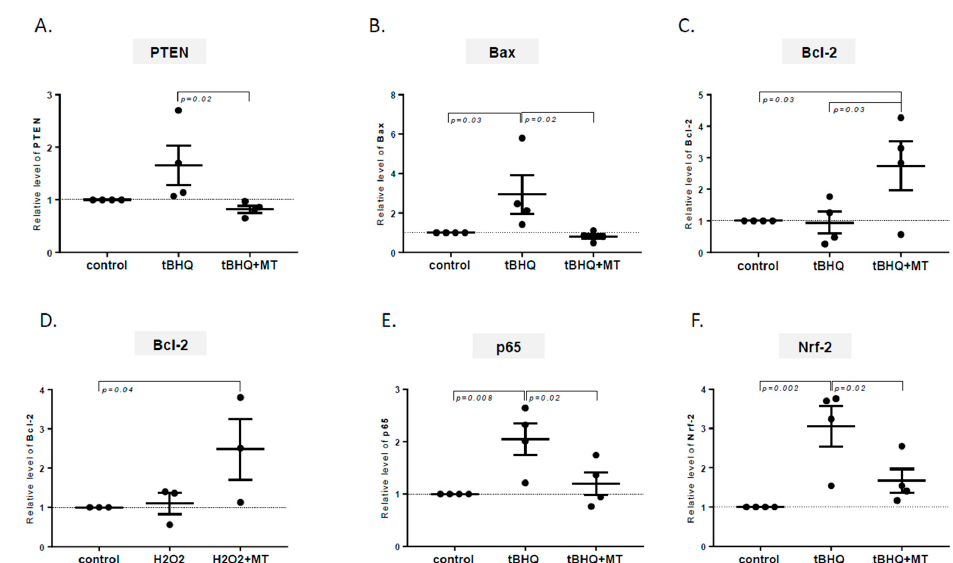
Figure 4. The effect of melatonin on apoptosis- and inflammation-related factors in H69-miR-506 cells subjected to oxidative stress. Melatonin inhibited the tert-Butylhydroquinone (tBHQ)-induced upregulation of proapoptotic factors ( A ) phosphatase and tensin homolog and ( B ) Bax, and induced expression of antiapoptotic factor B-cell lymphoma-2 in cells treated with ( C ) tBHQ and ( D ) H 2 O 2 . In cells subjected to mitochondrial oxidative stress, melatonin suppressed the expression of ( E ) p65, a subunit of nuclear factor-kappa B associated with inflammation, and ( F ) nuclear factor-erythroid 2-related factor 2, a marker of oxidative stress. Each experiment was repeated four times with similar results. All factors were estimated using real-time PCR. The results were normalized to 18S RNA. Values are shown as mean ± SE.